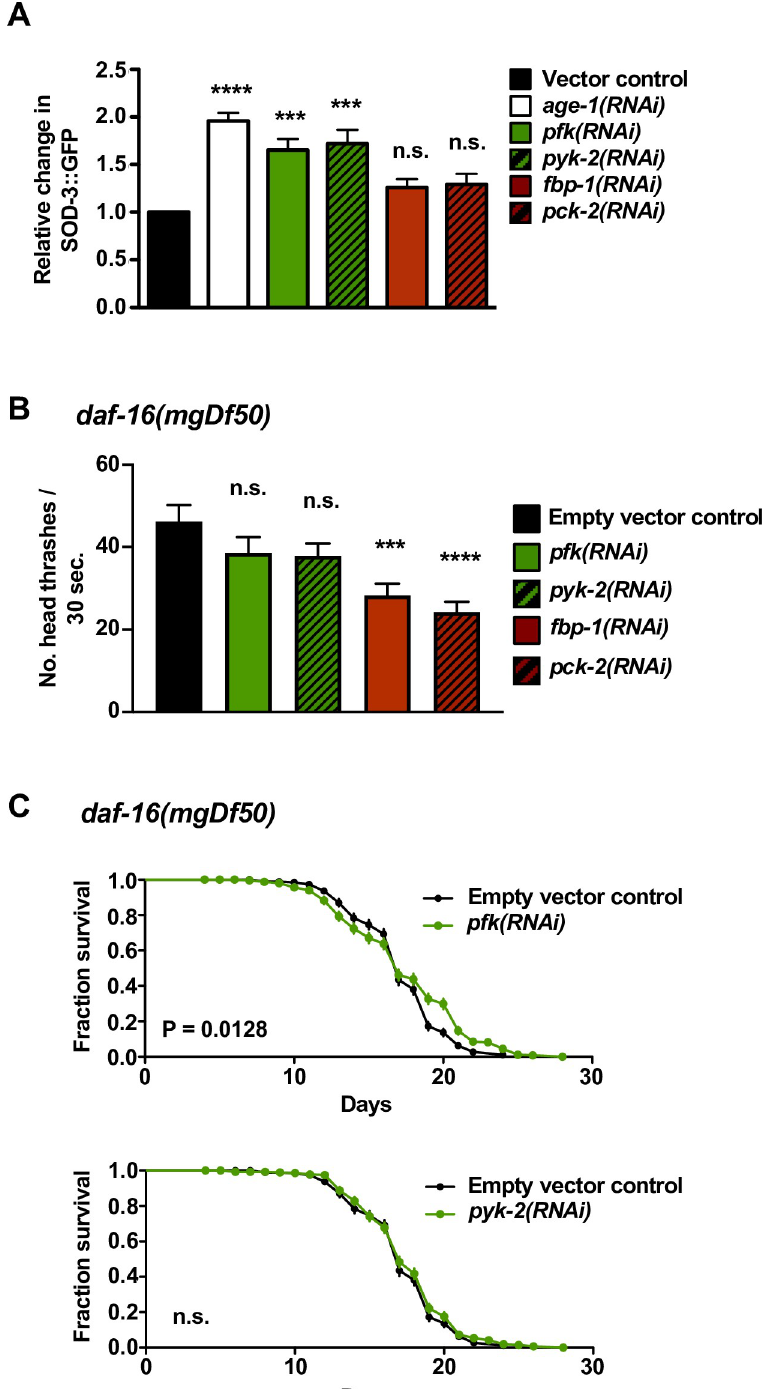
Fig 2. DAF-16/FOXO is Required for Locomotory Healthspan and Lifespan Benefits of Genetic Glycolysis Disruption. (A) Fluorescence intensity levels of wild-type animals expressing a GFP transcriptional reporter for sod-3 , which expresses superoxide dismutase and is a direct transcriptional target of DAF-16. We measured in vivo fluorescence using a spectrofluorimeter on day 5 of life. As expected from previous work [74], decreased insulin signaling with age-1(RNAi) results in increased SOD-3::GFP expression. Similarly, knockdown of glycolytic genes via pfk(RNAi) and pyk-2(RNAi) significantly increases SOD-3::GFP fluorescence levels. Disrupting the fbp-1 and pck-2 gluconeogenic genes, on the other hand, does not significantly change GFP fluorescence levels. Data are